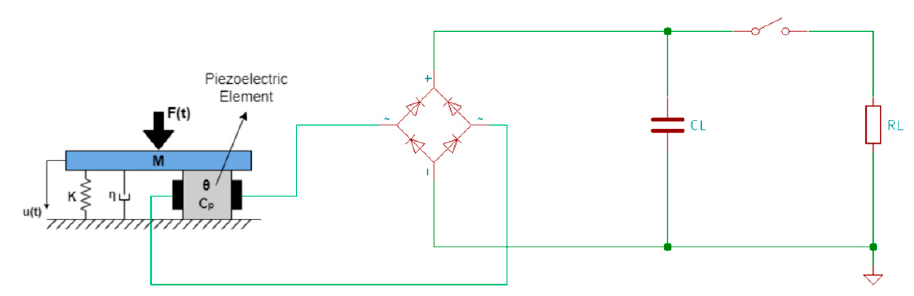
Figure 16. Standard AC-DC energy harvesting circuit with electromechanical piezoelectric